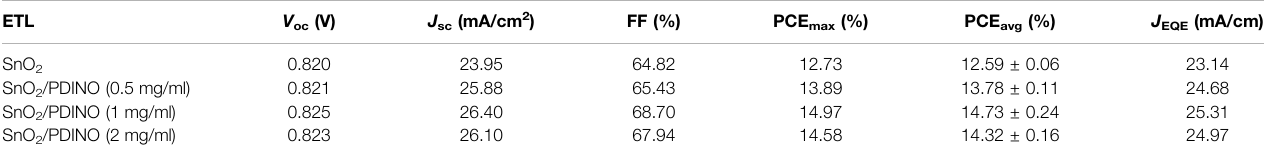
TABLE 1 | Photovoltaic performance metrics of OSCs with pristine SnO 2 and different concentrations of PDINO-modi fi ed SnO 2 as ETLs. The average PCE (PCEavg) value was obtained form 20 devices fabricated in parallel. ETL